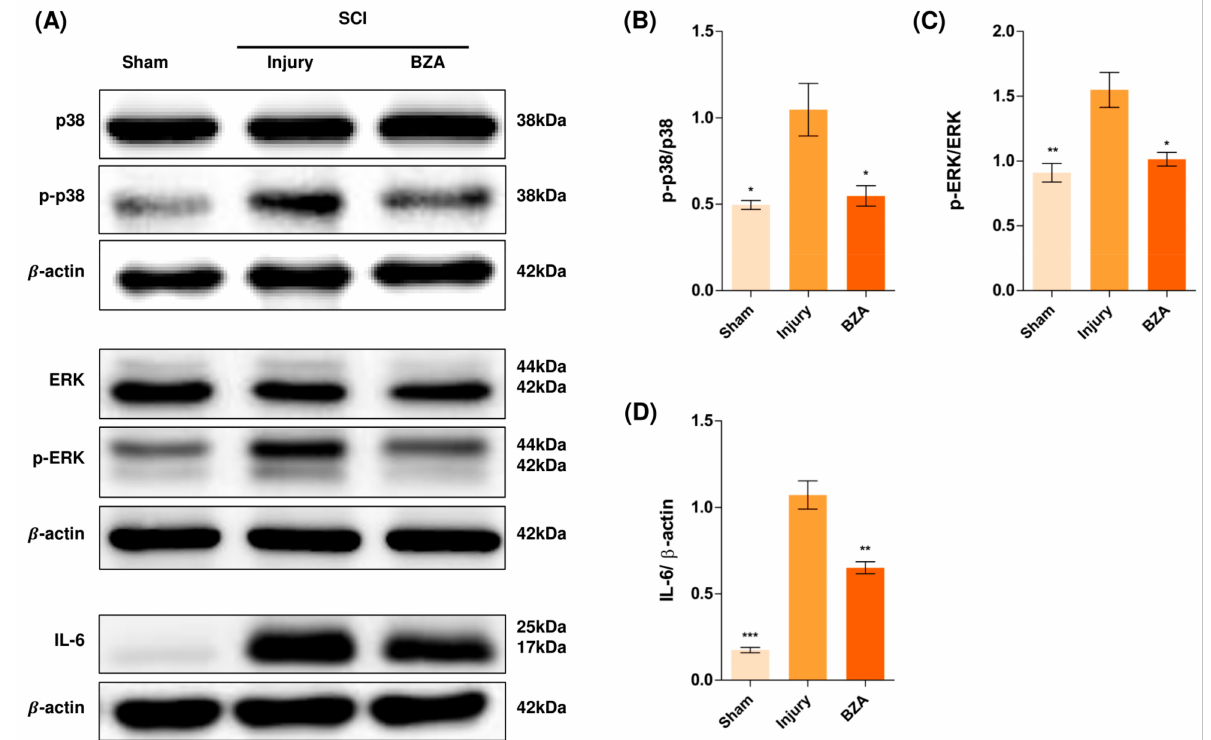
Figure 5. BZA downregulates the phosphorylation of ERK and p38 pathways. BZA decreases phosphorylation of ERK1/2 and p38, resulting in neuroprotection, OPC differentiation, and remyelination. ( A ) Representative images of western blots for p38, p-p38, ERK, p-ERK, IL-6. The graph was quantified as ( B ) p-p38/p38, ( C ) p-ERK/ERK and ( D ) IL-6. Western blot results of the graph confirmed the significance between the injury group and the sham and BZA groups. All data represent mean ± SEM ( n = 3; performed in triplicate). * p < 0.05, ** p < 0.01, *** p < 0.001 (injury vs. sham, BZA), NS = Not significant, one-way ANOVA followed by the Bonferroni